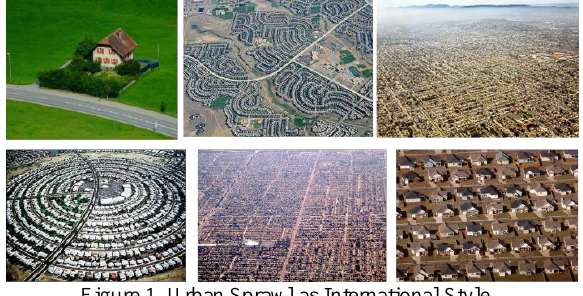
Figure 1. Urban Sprawl as International